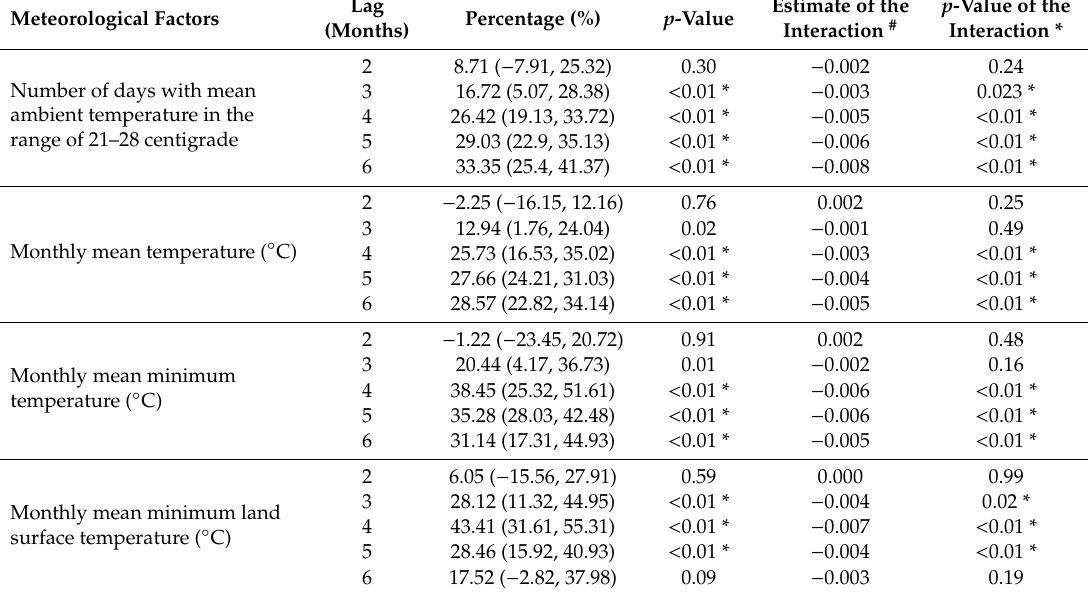
Table 3. Percent change of VL events associated per unit increase of temperature-related factors from multiple-variable models.